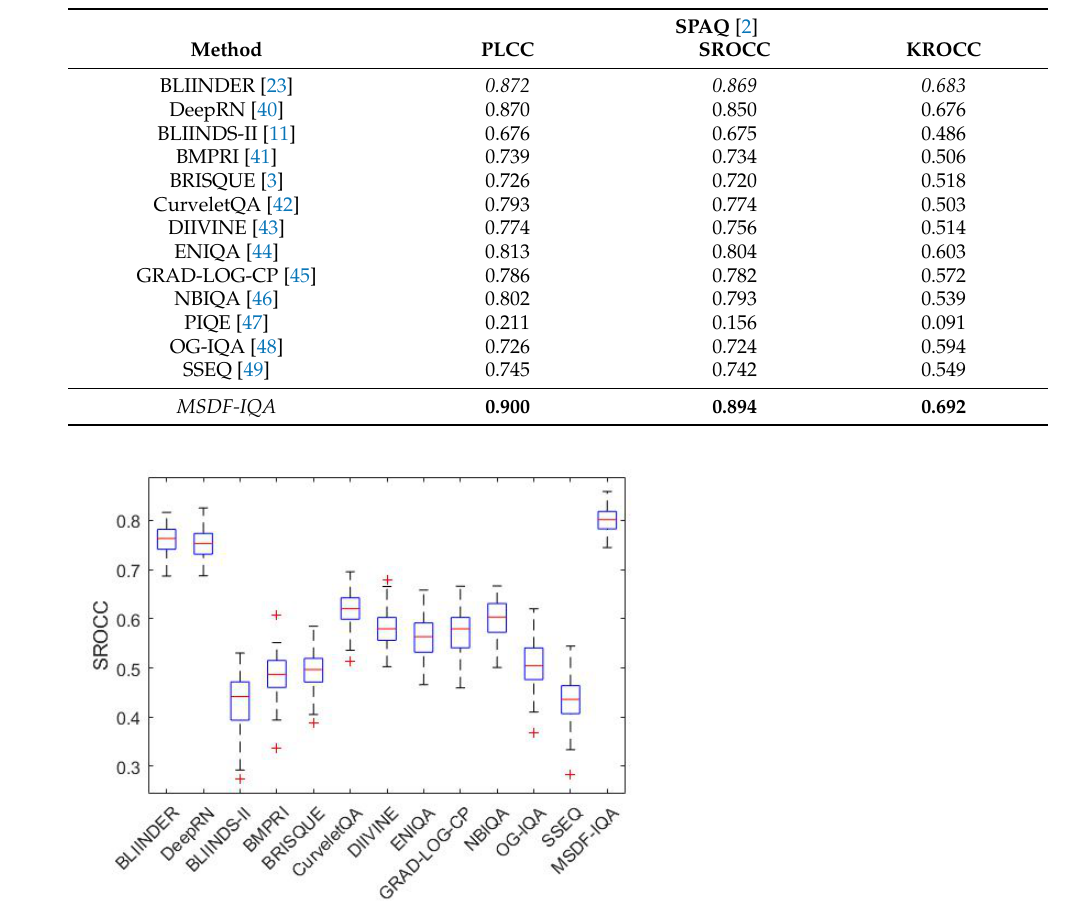
Table 8. Comparison of MSDF-IQA to the state-of-the-art on authentic distortions (SPAQ [2]). Median PLCC, SROCC, and KROCC values were measured over 100 random train–test splits. Best results are typed in bold, and second best results are typed in italic.